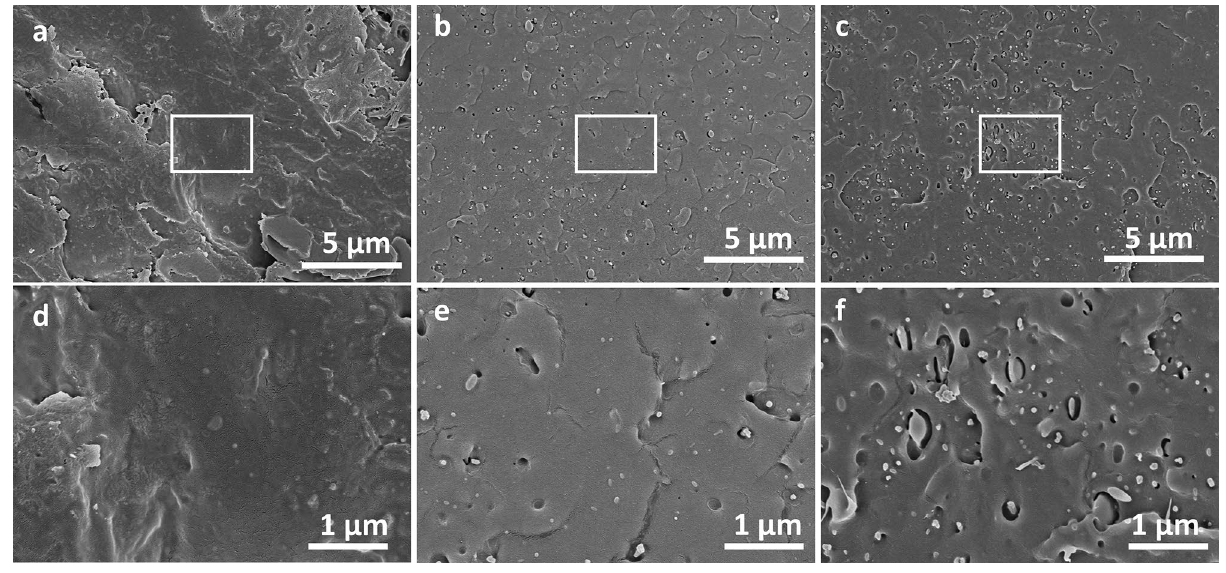
Figure 7. SEM images of DIRTS after having been buried in various media for 3 months ( a ) Cross-section of DIRTS placed in an airtight sealed container demonstrating negligible pore formation after 3 months ( b ) A relatively higher levels of porosity observed in soil ( c ) Maximum porosity observed in accelerated biodegradation environment indicating highest level of degradation. ( d–f ) High magnification images of DIRTS corresponding to the insets demarcated by white boxes in a, b, and c, respectively. [Scale bars: 5 µm for (a-c) and 1 µm for (d-f)].